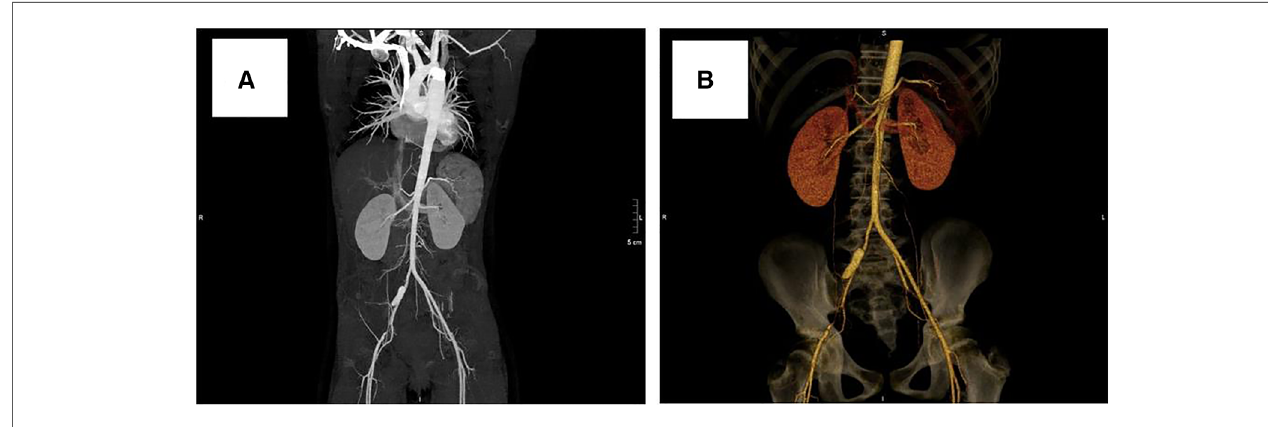
FIGURE 4 Computed tomography scan showing dissection of the right femoral artery: ( A ) 3 days after stenting, ( B ) 3 years after